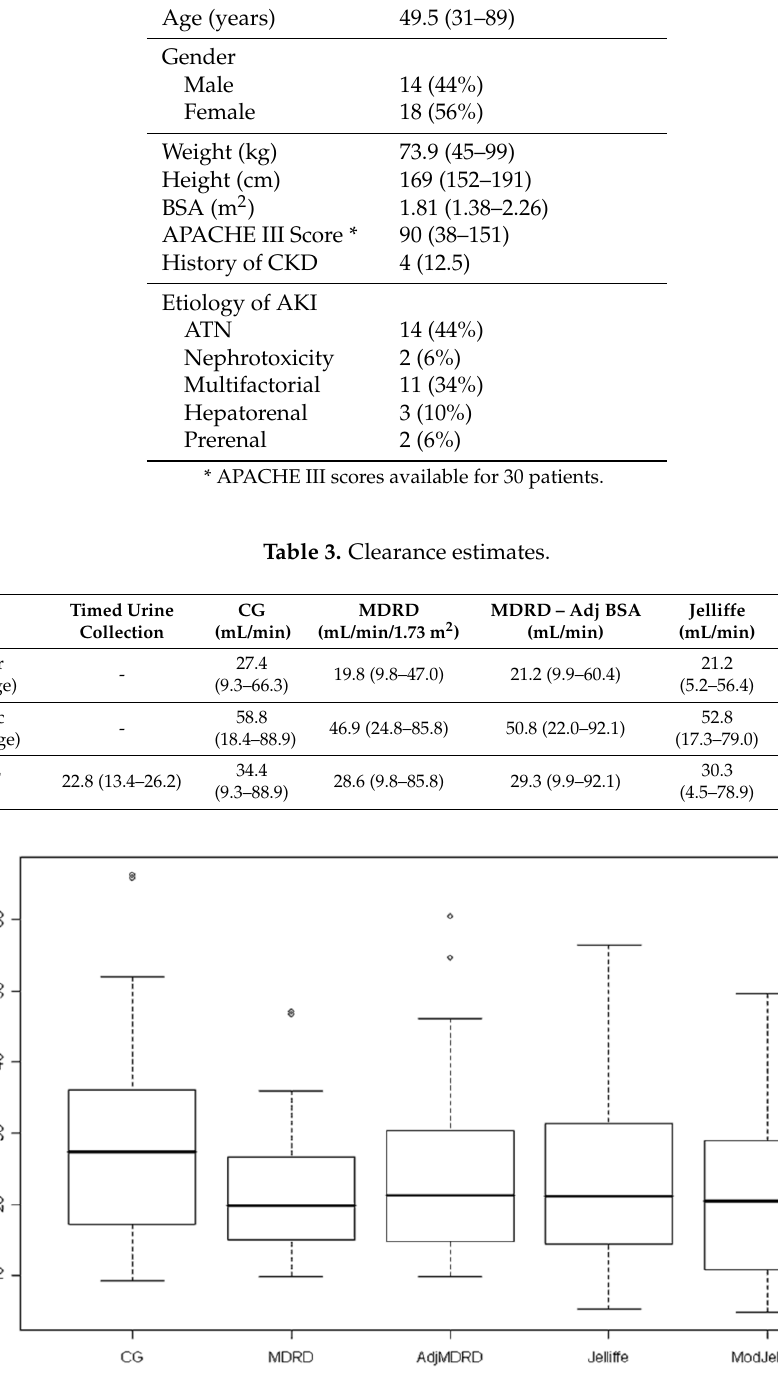
Figure 1. Clearance estimates at peak of kidney injury. This figure depicts the calculated median clearance using the peak serum creatinine value in each estimating equation. The circles represent outlier data points.